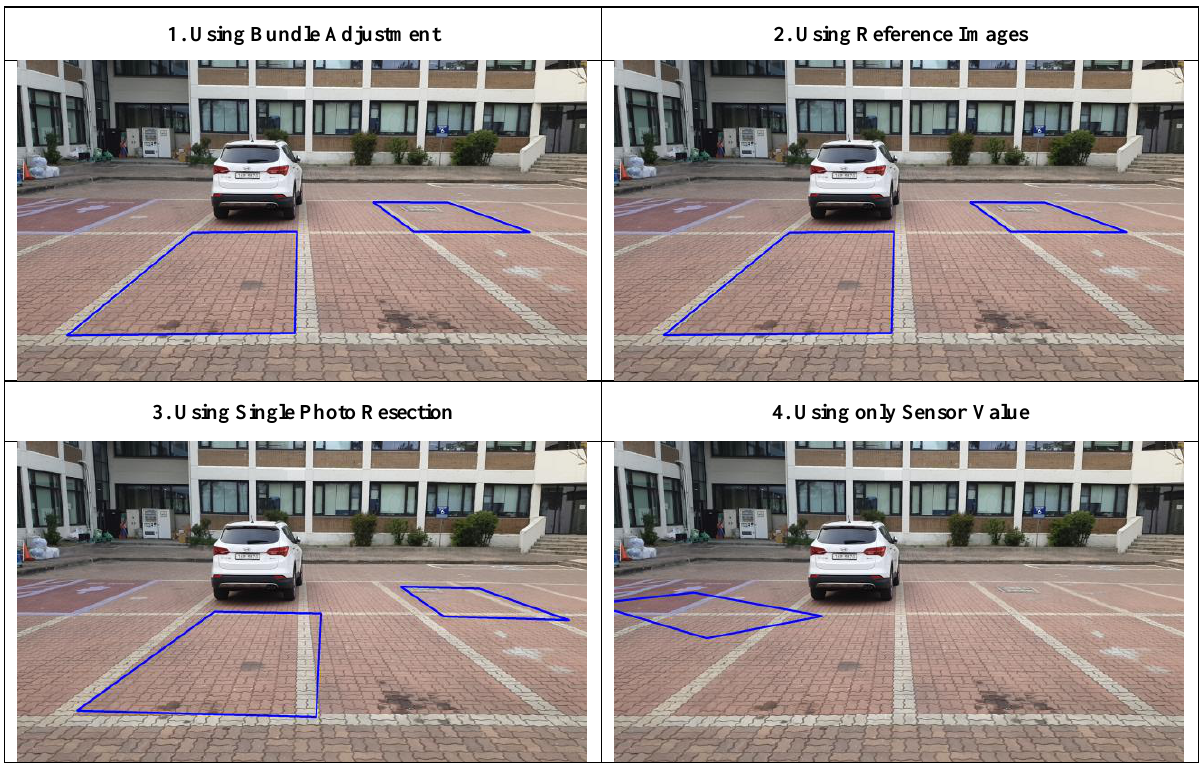
Figure 5. Visualization of the first image